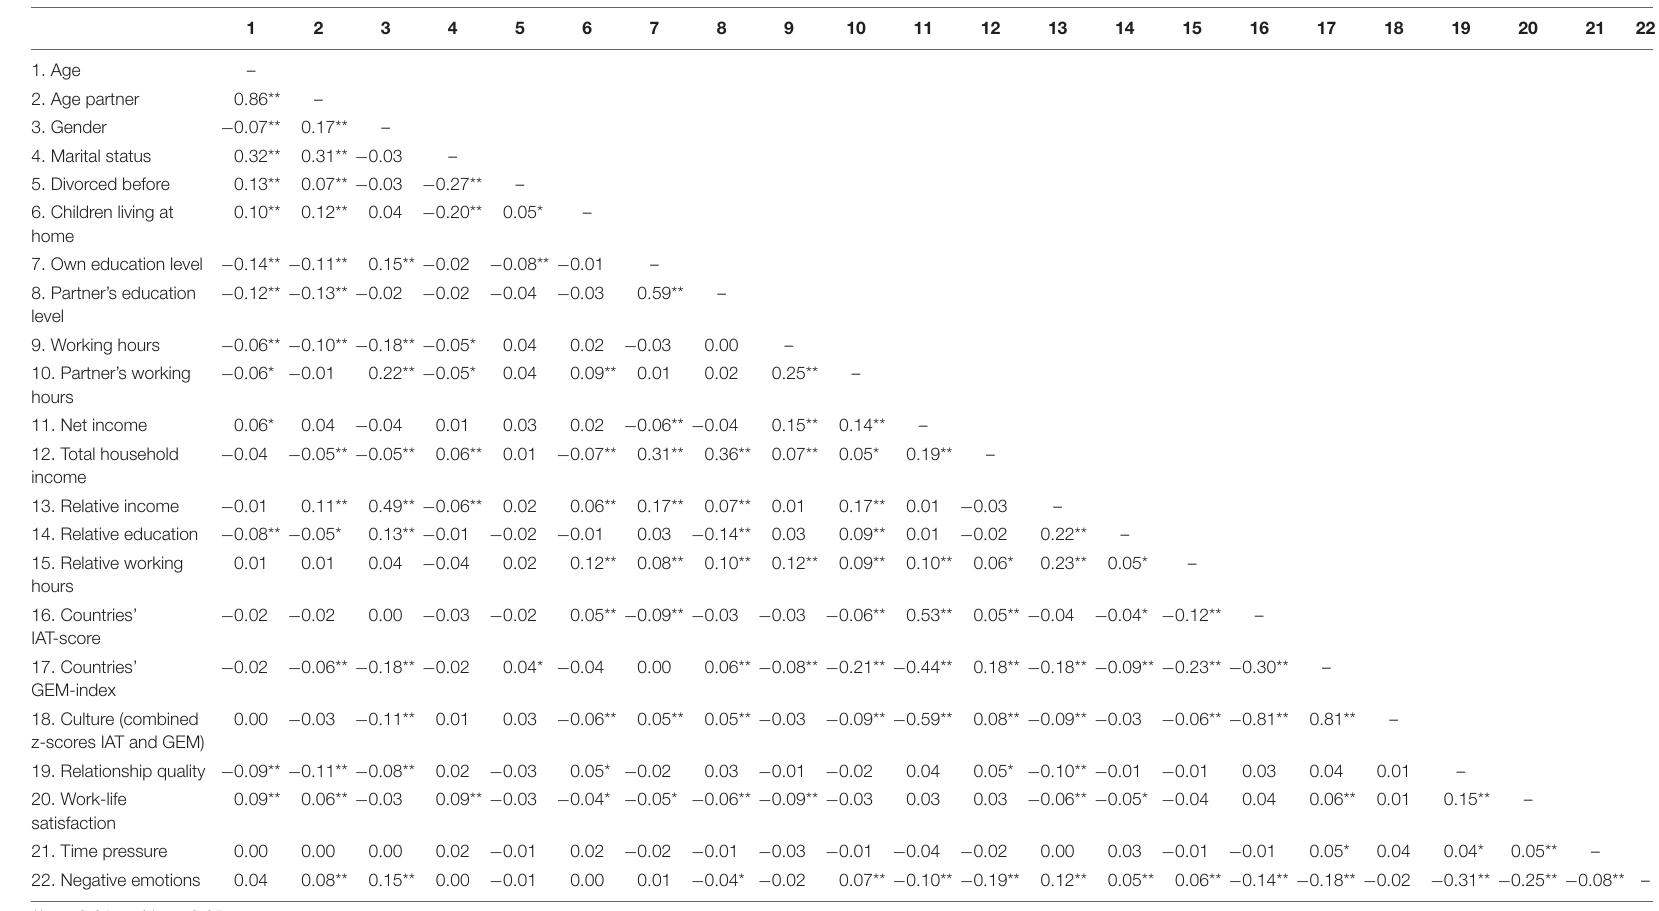
TABLE 3 | Correlation analyses of background, independent, and dependent